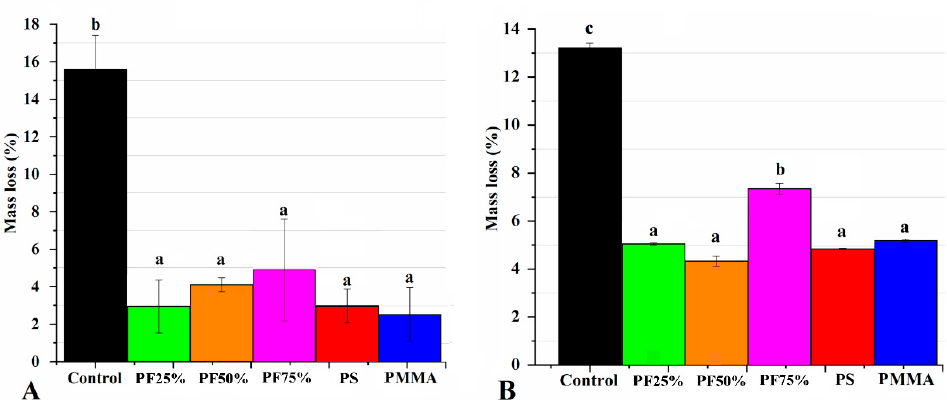
Figure 3. Mass losses for control and treated pine woods exposed to termite attack using choice ( A ) and no-choice ( B ) feeding tests. Where PF25% is 25% of poly (furfuryl alcohol), PF50% is 50% of poly (furfuryl alcohol), PF75% is 75% of poly (furfuryl alcohol), PS is poly (styrene) and PMMA is poly (methyl methacrylate). Different letters above the bars indicate statistically different averages.